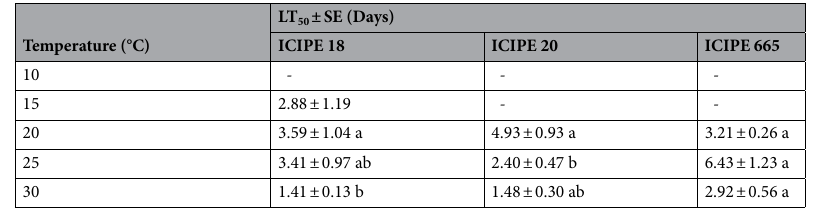
Table 2. LT 50 values 12 days post-exposure of adult Tuta absoluta to Metarhizium anisopliae fungal isolates dry conidia under different temperatures. Means within a row followed by the same lower letter case are not significantly different (Tukey’s HSD test, P = 0.05). Dash (-) means the LT 50 value was not estimated for cumulative mortality less than 50% at 12 days